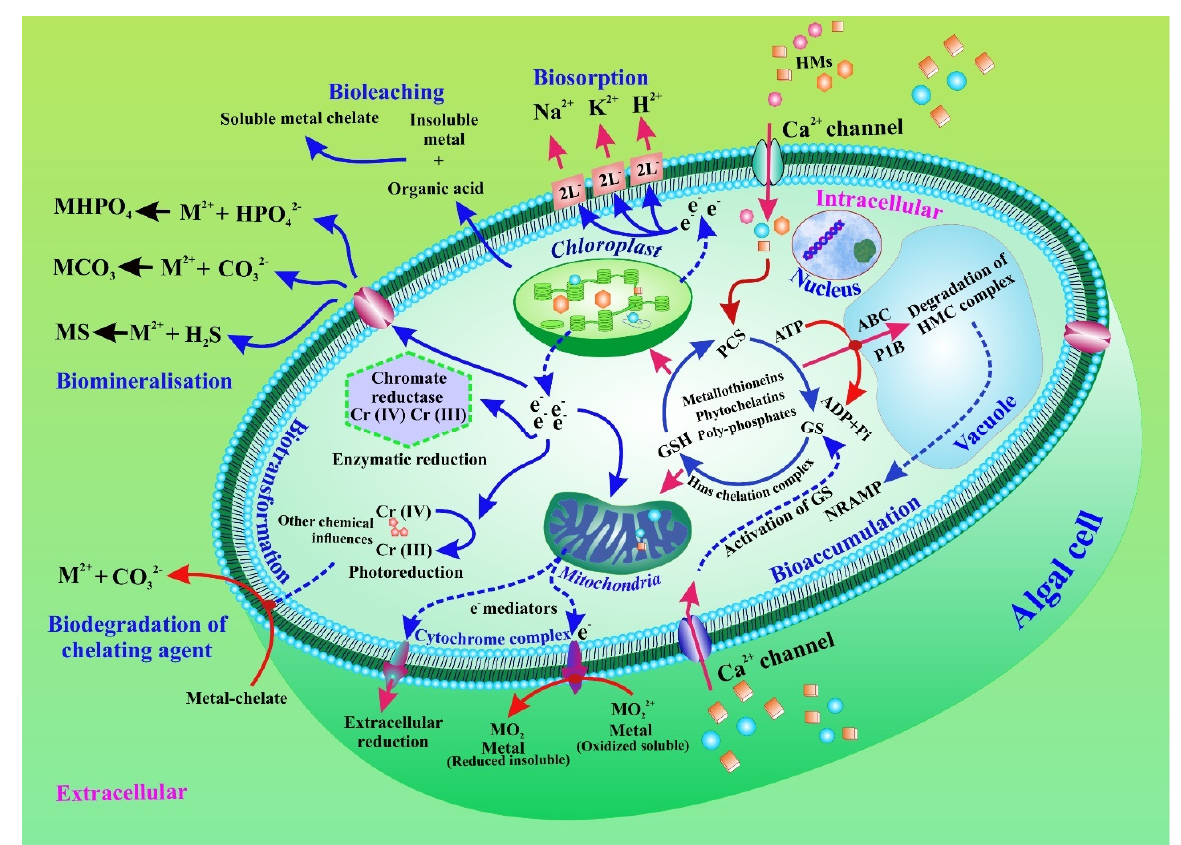
Figure 2. Bioremediation of heavy metals and metalloids in microalgae through accumulation and intra- and extracellular biotransformation. Biotransformation, bioleaching, and biomineralization are also displayed.